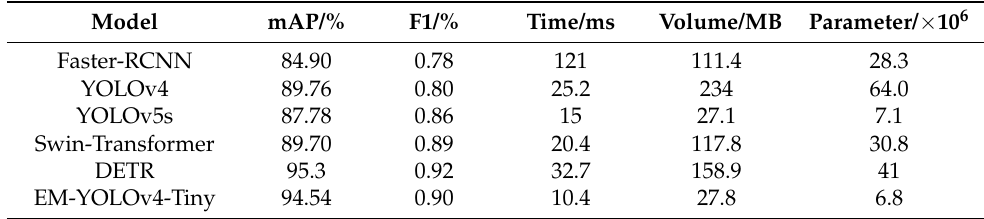
Table 6. Performance comparison results of multiple target detection